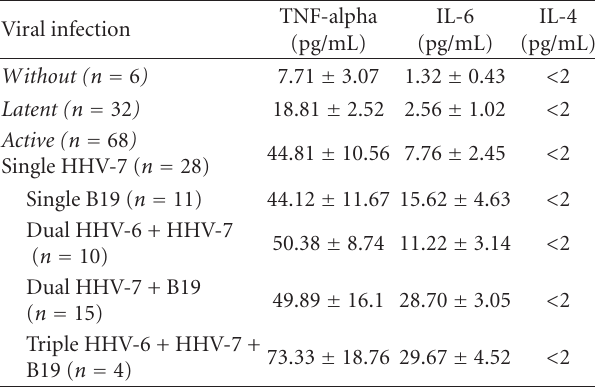
Table 2: Plasma cytokine levels in patients with